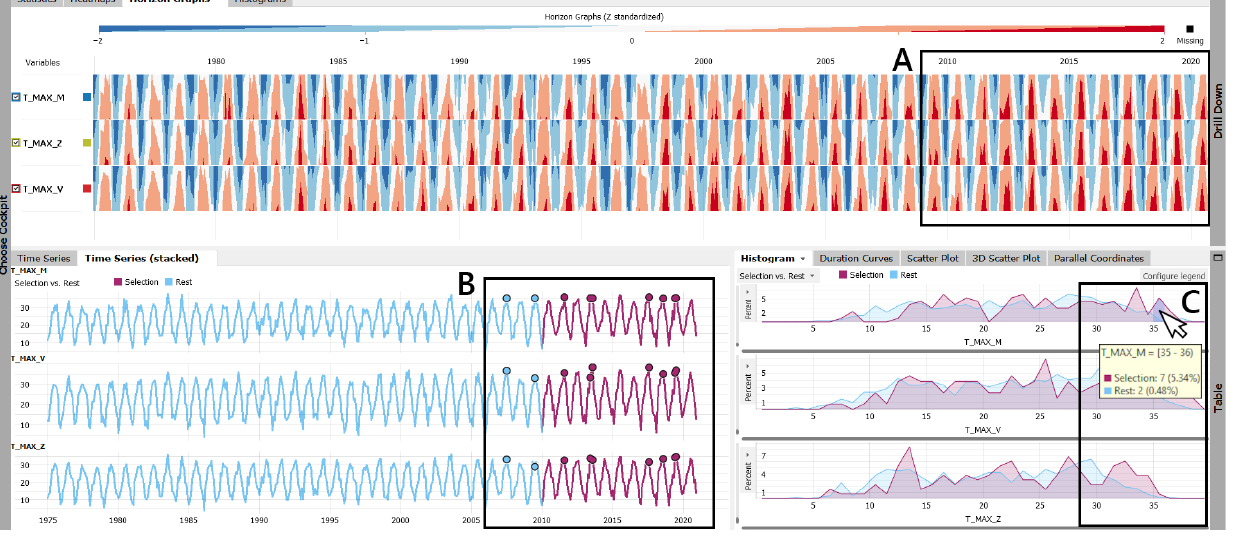
Figure 4. Warming progression denoted for air temperature minima with higher frequency of temperatures not exceeding − 5 °C in the past 10 years in comparison to the remaining 35 years: ( A ) the observed higher representation of temperature peaks marked in red; ( B ) the highlighted individual data points denoting instances of air temperature below − 5 °C in 2010–2020 period; ( C ) shifting of the frequency area towards generally higher values for temperature minima.